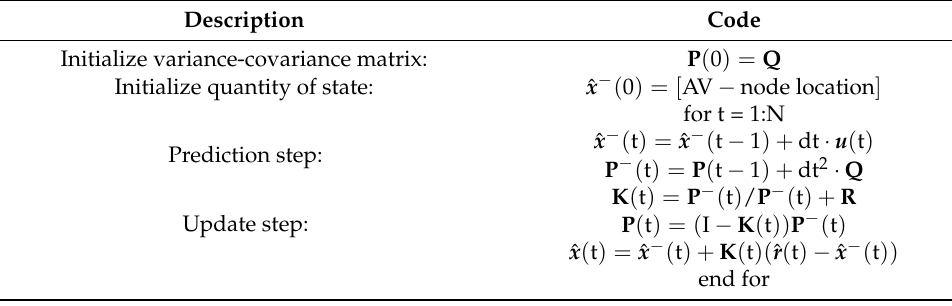
Table 3. Pseudocode for estimated localization correction using Kalman